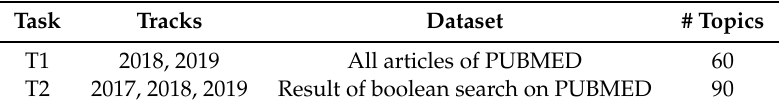
Table 1. Summary of the datasets